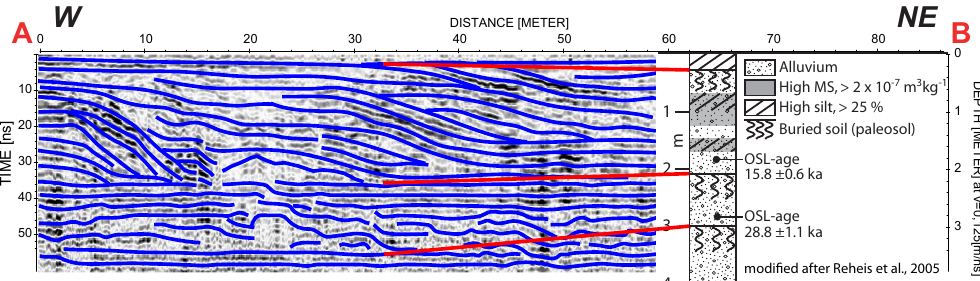
Figure 20. 400MHz profile of central Cyclone Canyon with overlay of the profile and OSL ages of Reheis et al. (2005). Three horizontal layers in the GPR profile fit well to paleosols from outcrop profile with an error of less than